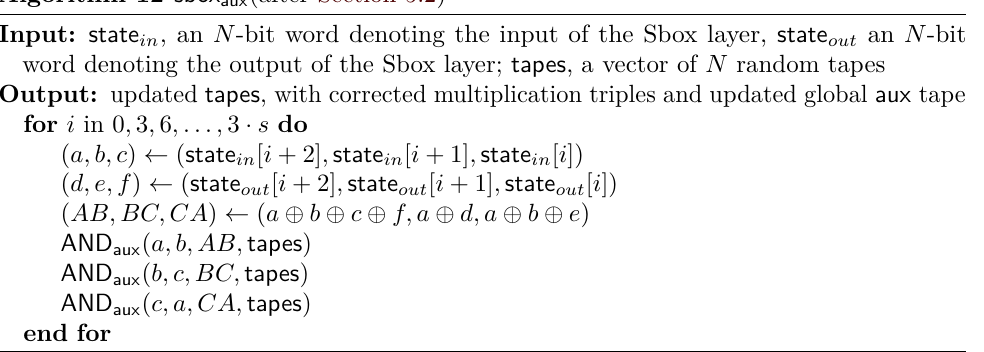
Algorithm 12 sbox aux (after Section